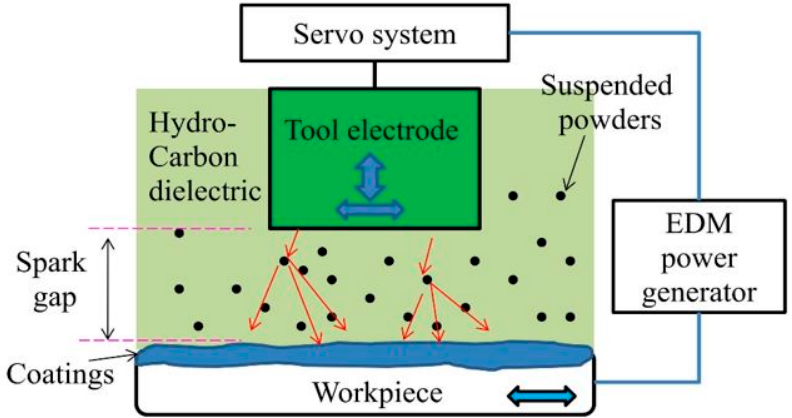
Figure 17. Schematic of powder mixed EDC [78].